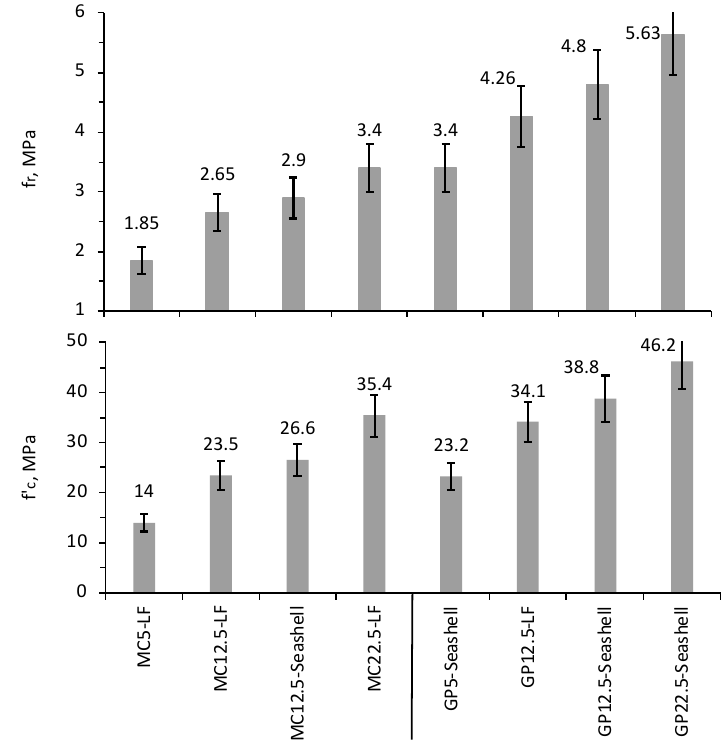
Figure 4. Variations in 28 d f (cid:48) c and f r responses for MC and GP